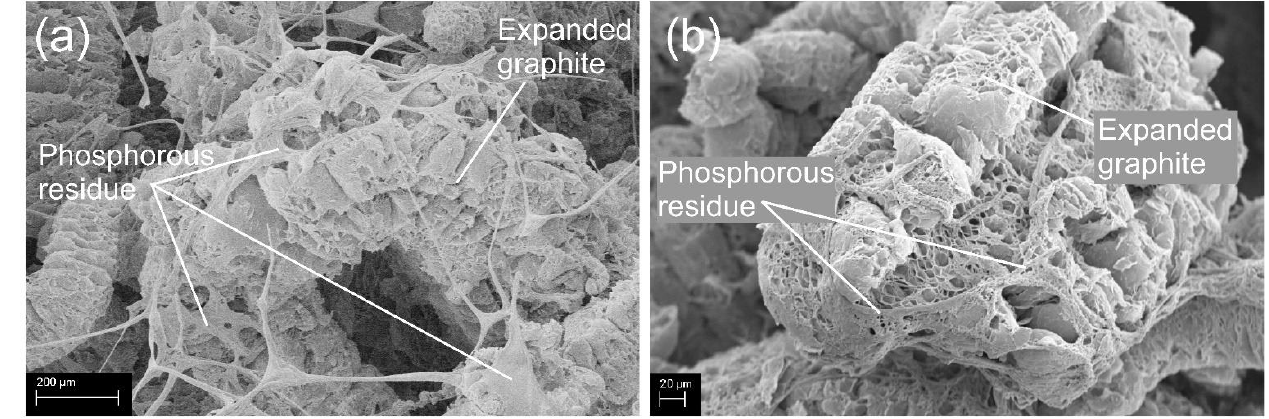
Figure 11. Phosphorous residue acts as a binder for expanded graphite in FPUFs.